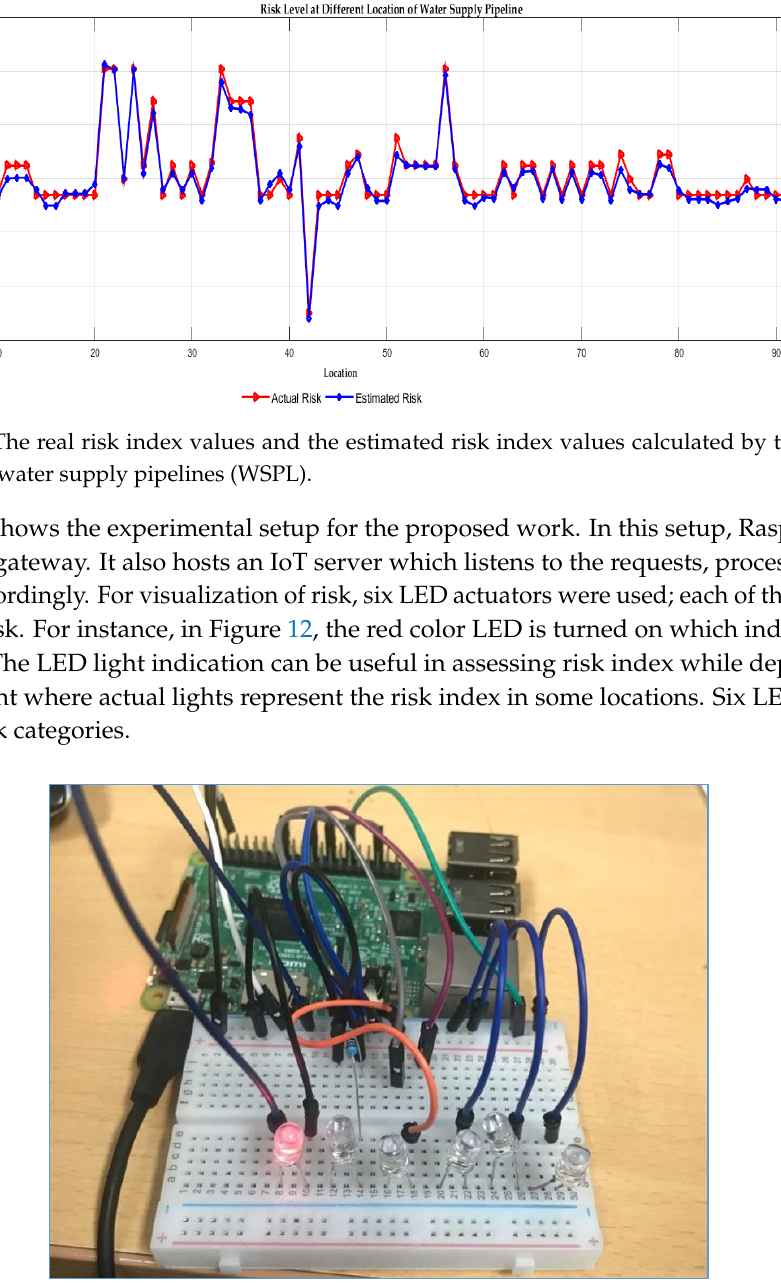
Figure 12. The experimental environment for the risk index of CHFIS model.